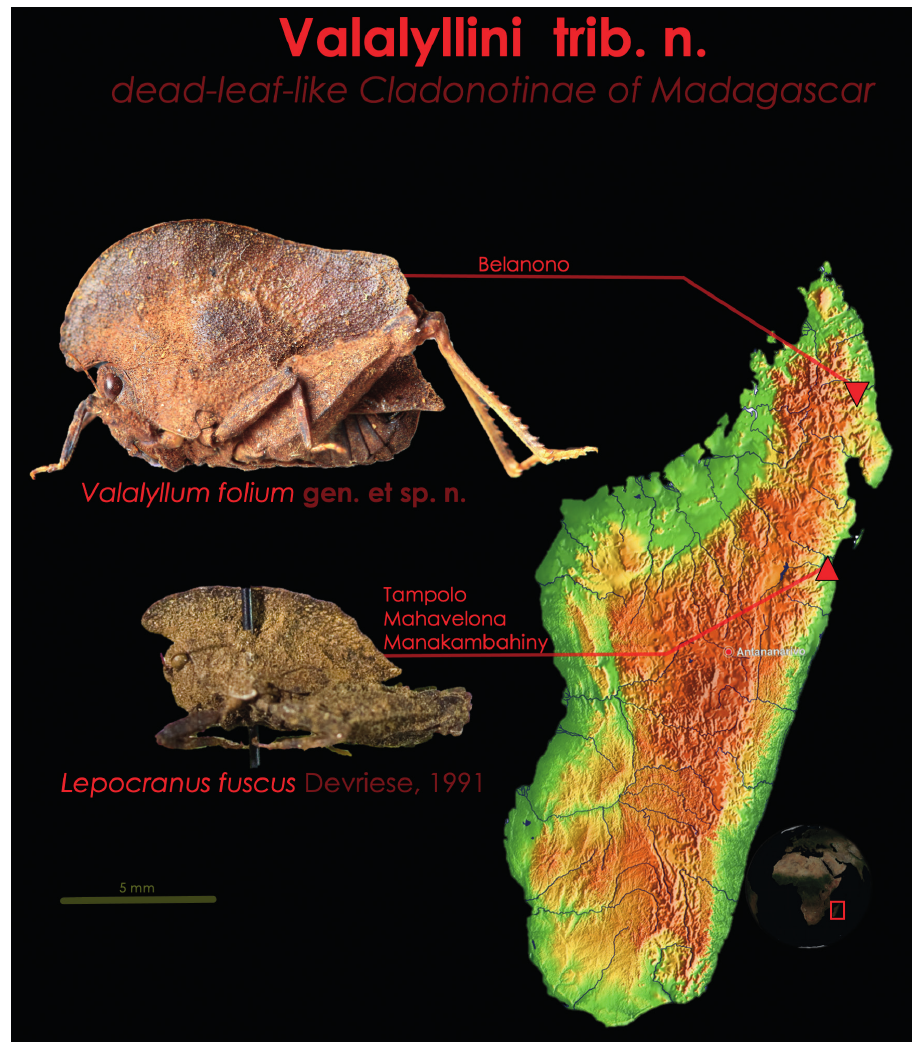
Figure 3. The diversity and the distribution of the tribe Valalyllini trib. nov. ( Valalyllum folium gen. et sp. nov. in the north, and Lepocranus fuscus in the south), the Malagasy dead-leaf-like Cladonotinae. Both species are endemic to small areas and are likely endangered because of deforestation. Both species most probably inhabit rainforest leaf